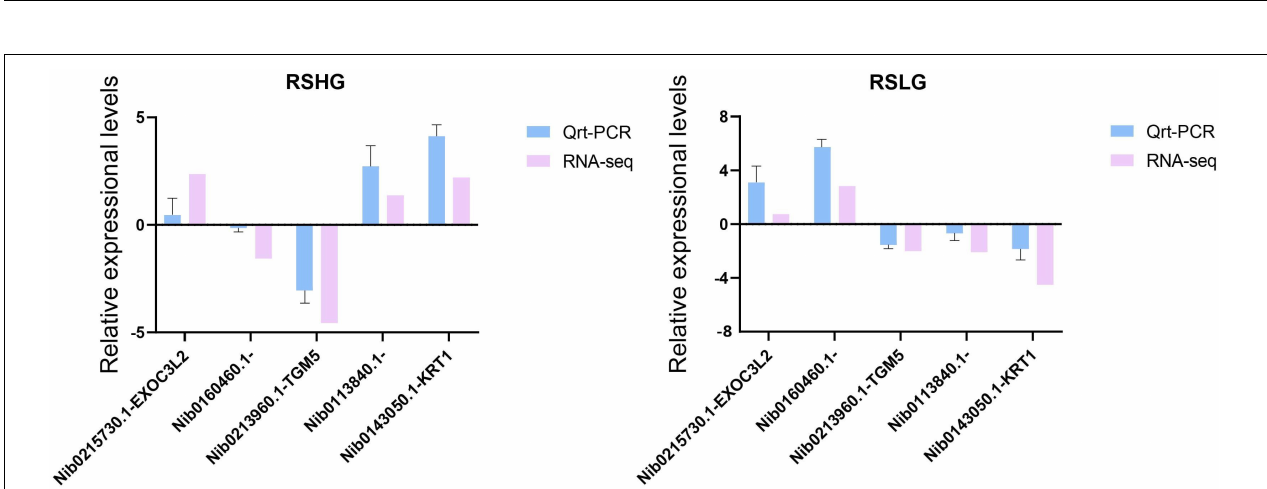
FIGURE 8 | Validation of differentially expressed genes in RNA-seq by real-time PCR.